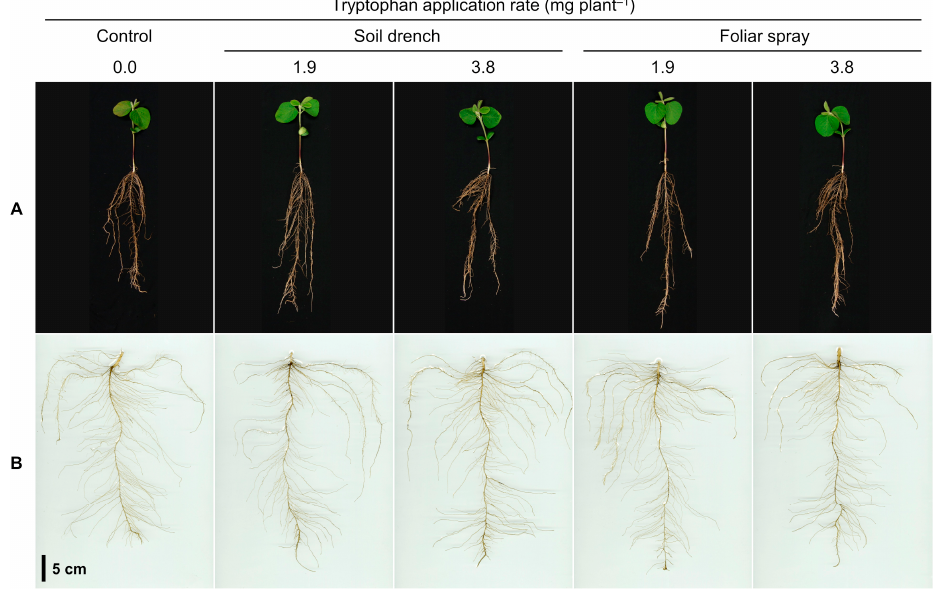
Figure 3. Soybean seedlings sampled at 18 days after sowing: ( A ) photographs; ( B ) scan images of washed roots. Tryptophan treatments were as described in Figure 1. Table 3. Root diameter and lateral root number of soybean seedlings as affected by tryptophan (TP) soil drench and foliar spray treatments 1 .